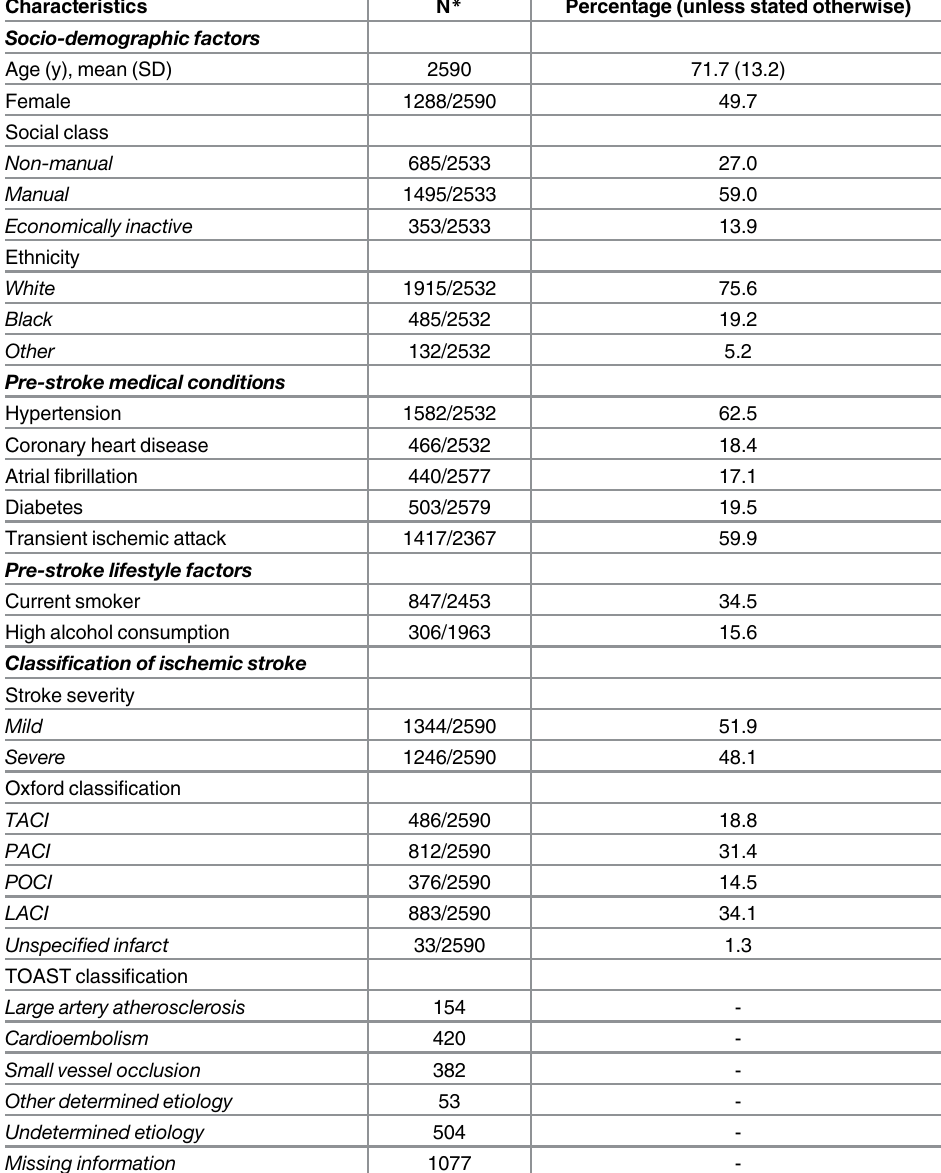
Table 1. Characteristics of patients with ischemic stroke, South London Stroke Register 1995 – 2006.